Question: Provide a one-line summary of what is displayed.
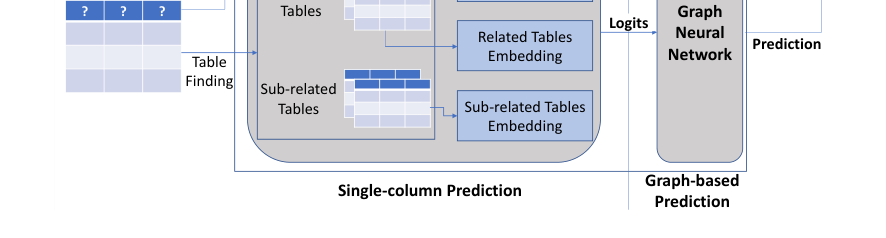
Answer: shows the framework of GAIT. It is built on a single-column predic- tion provided by RECA. We opted for RECA due to its high performance in column type annotation as a result of incorporating useful inter-table informa- tion from other relevant tables. That said, GAIT’s design is versatile. While we utilize RECA, other single-column prediction modules can be integrated. GAIT